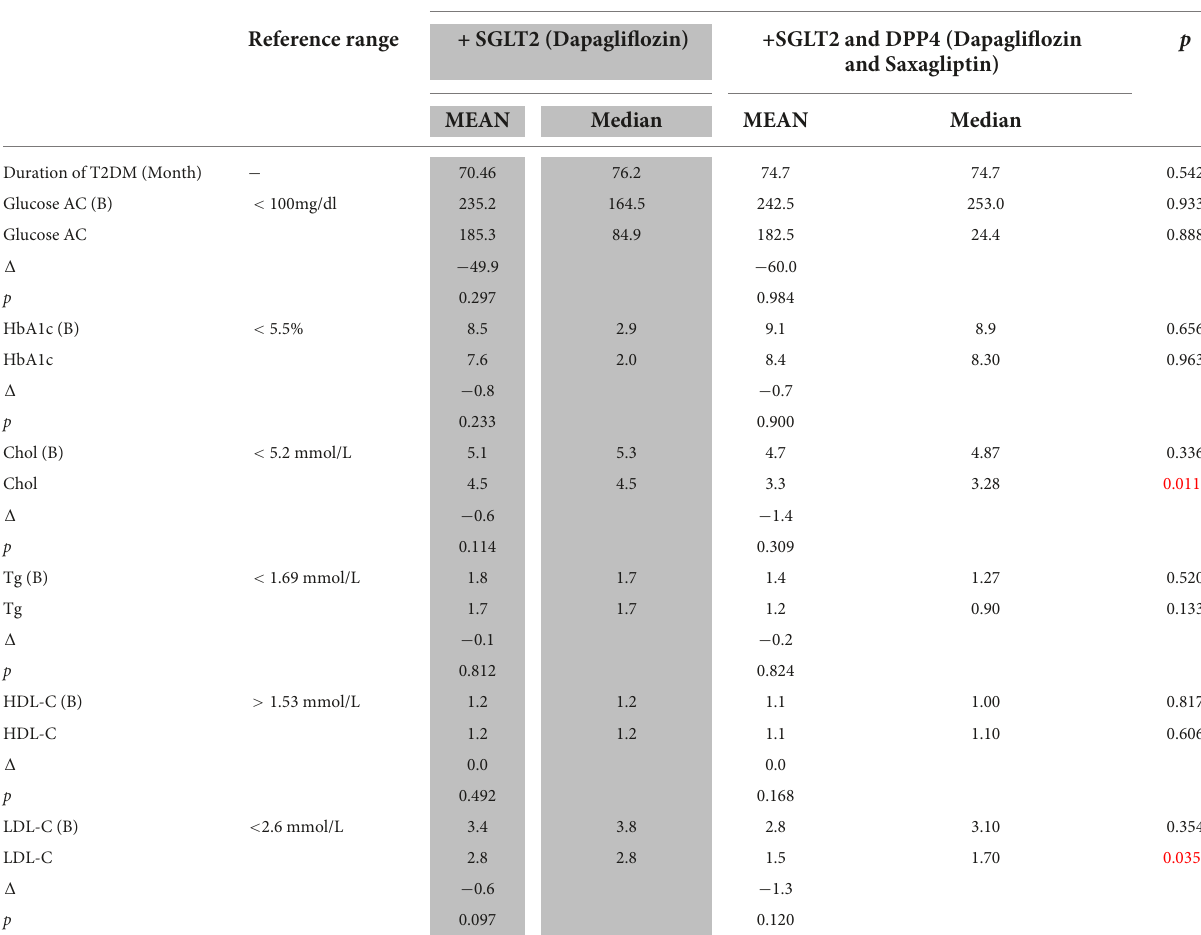
GlucoseAC:fastingbloodglucose;HbA1c:glycosylatedhemoglobin;Chol:totalcholesterol;Tg:triglyceride;LDL-C:low-densitylipoproteincholesterol;HDL-C:high-densitylipoprotein cholesterol.* p <